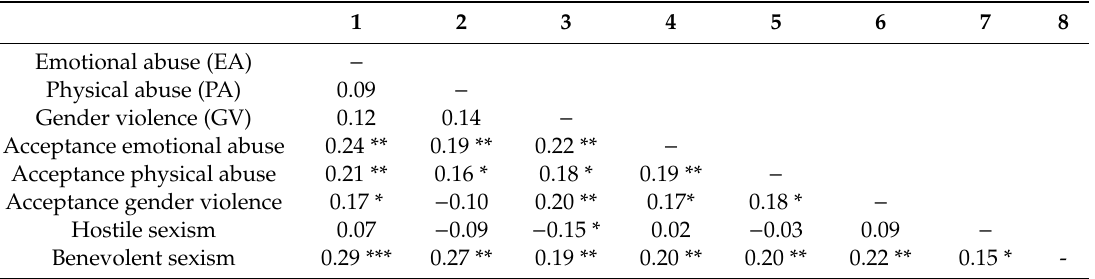
Table 2. Correlations between